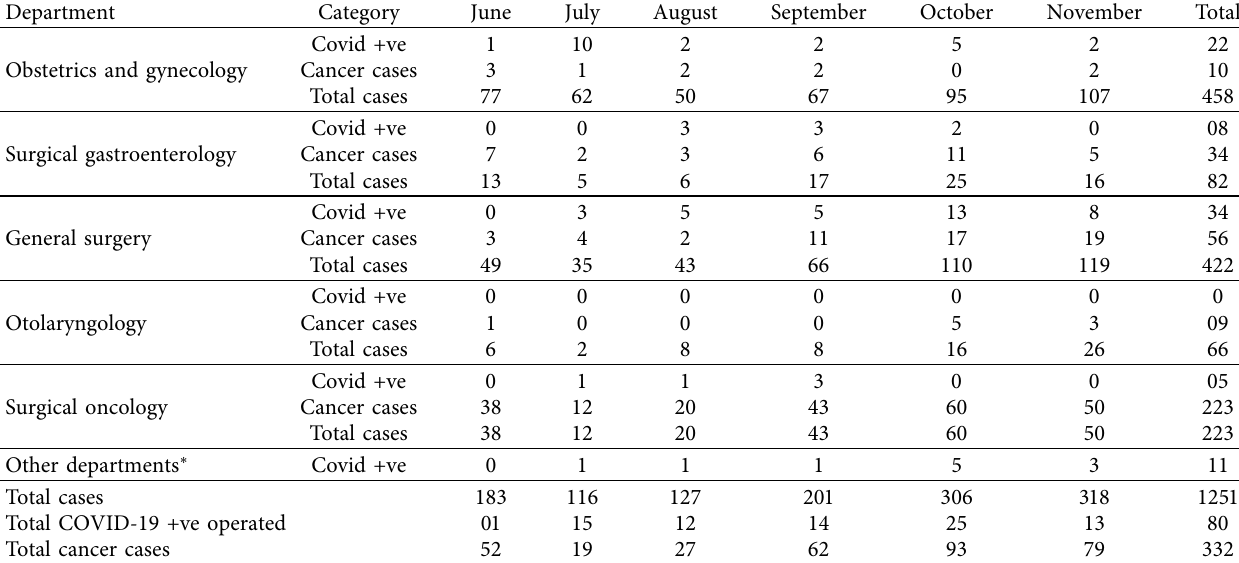
Table 3: Department-wise COVID-19 positive cases.